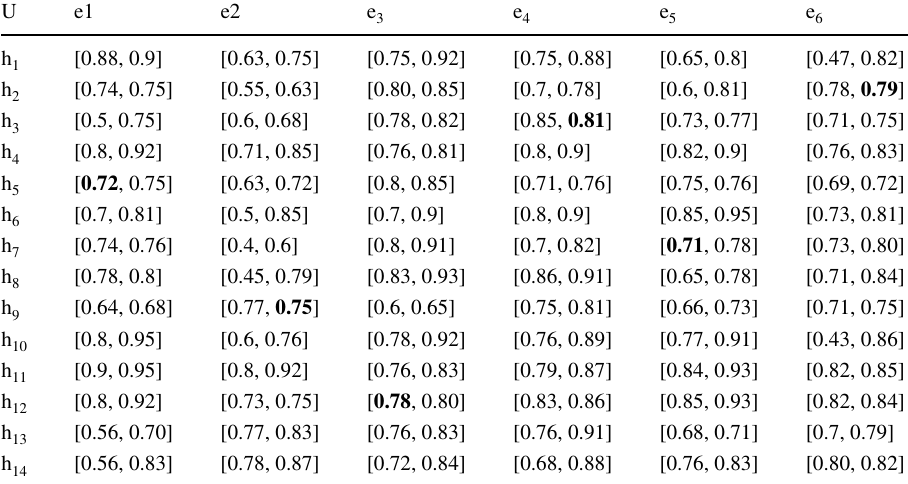
Bold indicates the data after